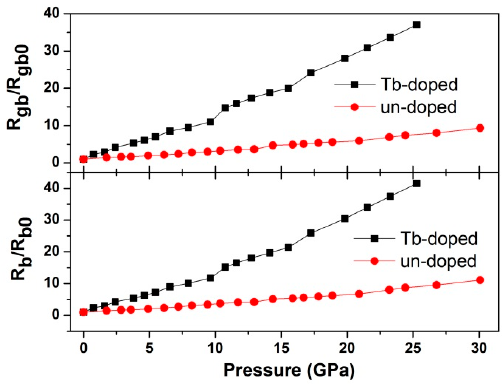
Figure 8. The R b /R b 0 and R gb /R gb 0 of Tb-doped and un-doped CaF 2 nanocrystals. R b 0 and R gb 0 represent bulk and grain boundary resistances at 0 GPa.